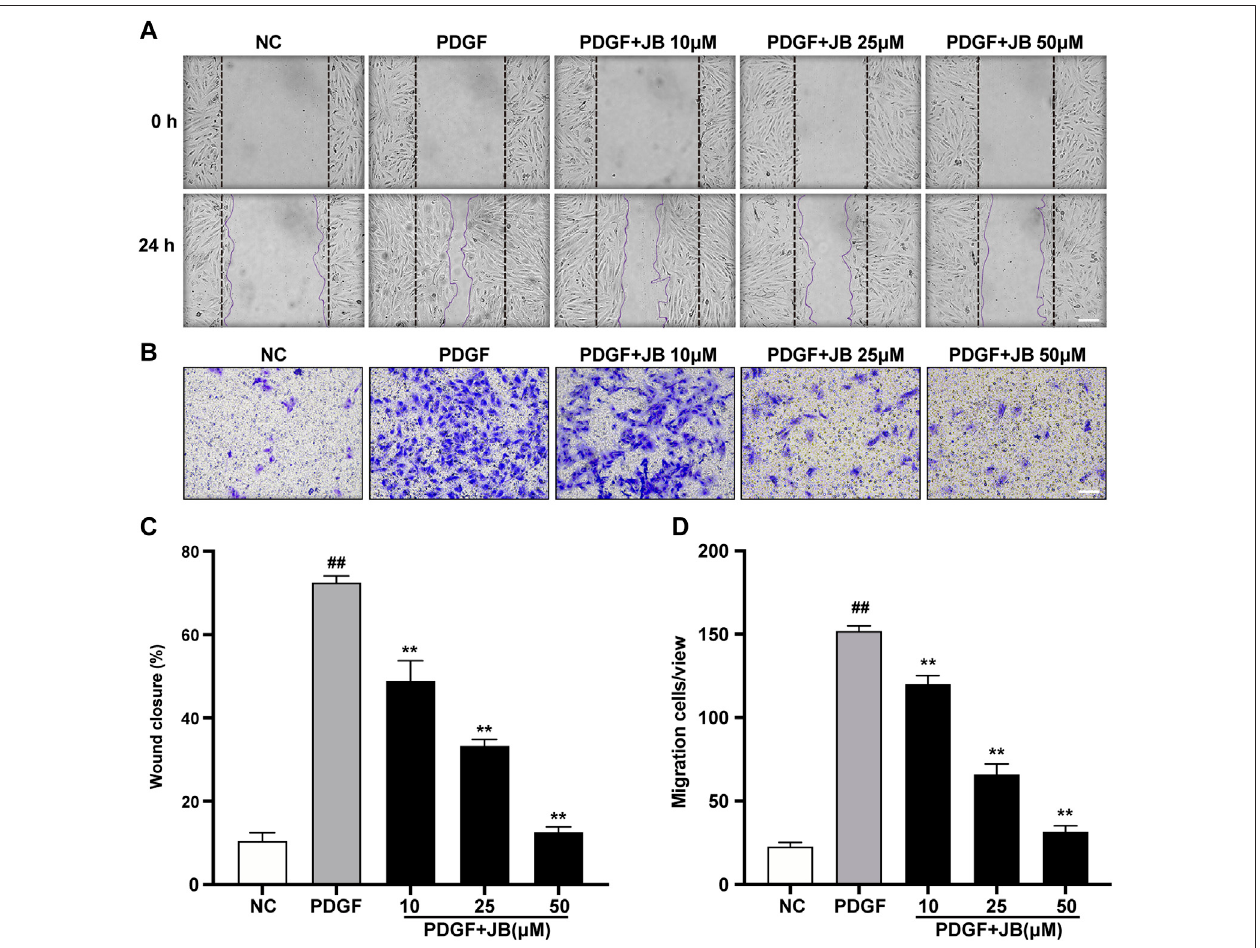
FIGURE 5 | JB inhibited the migration ofVSMCs induced byPDGF-BB. (A,C) Representative imagesofcellmigration bywound healing test (A) and quanti fi cation of wound healing ineachgroup (C) . Scale bar:100 μ m. (B,D) RepresentativeimagesofcellmigrationbyTranswell assay (B) and quanti fi cationofVSMCsstained withcrystal violet in each treatment group (D) . Scale bar: 100 μ m. Data are expressed as mean ± S.D. ## p < 0.01 vs. Control. ** p < 0.01 vs. PDGF-BB group. n (cid:1) 3.